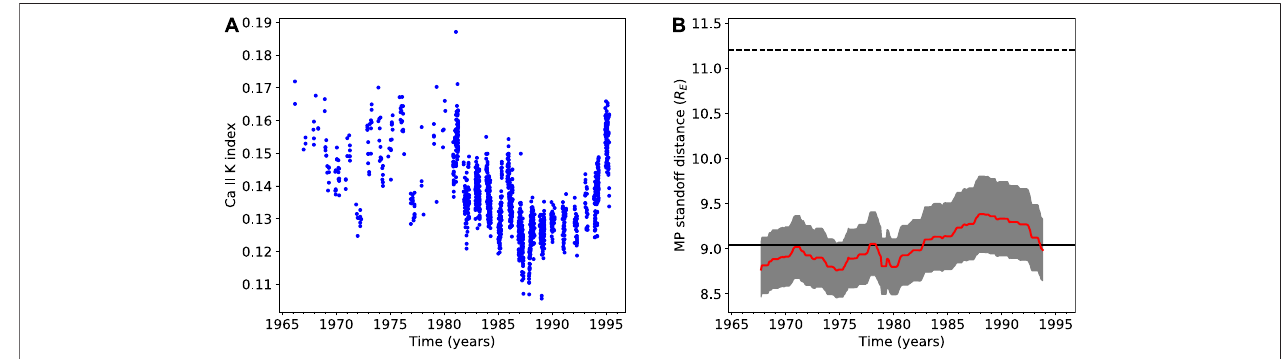
FIGURE 2 | (A) : Ca II K index of the star HD 76151 for the time interval 1966 – 1996, obtained from the MWO S-index measurements. (B) : Magnetopause standoff distance(redline,withcon fi denceintervalrepresentedbythegrayshadedarea)ofa fi ctitiousEarth-twinplanetorbitingat1AUaroundthesolar-typestarHD76151.The continuous black line indicates the mean value, while the dashed black line shows the mean Earth value as